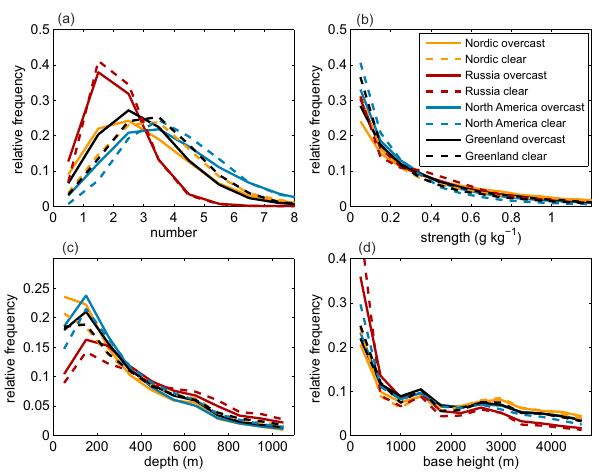
Fig. 6. Relative frequency distributions RFDs of (a) number of hu- midity inversions in a single profile, (b) inversion strength, (c) in- version depth and (d) inversion base height at each station in the geographical sectors. Bin sizes used in the RFDs are 1 for the in- version number, 0.1gkg − 1 for the inversion strength, 100m for the inversion depth and 200m for the inversion base height.